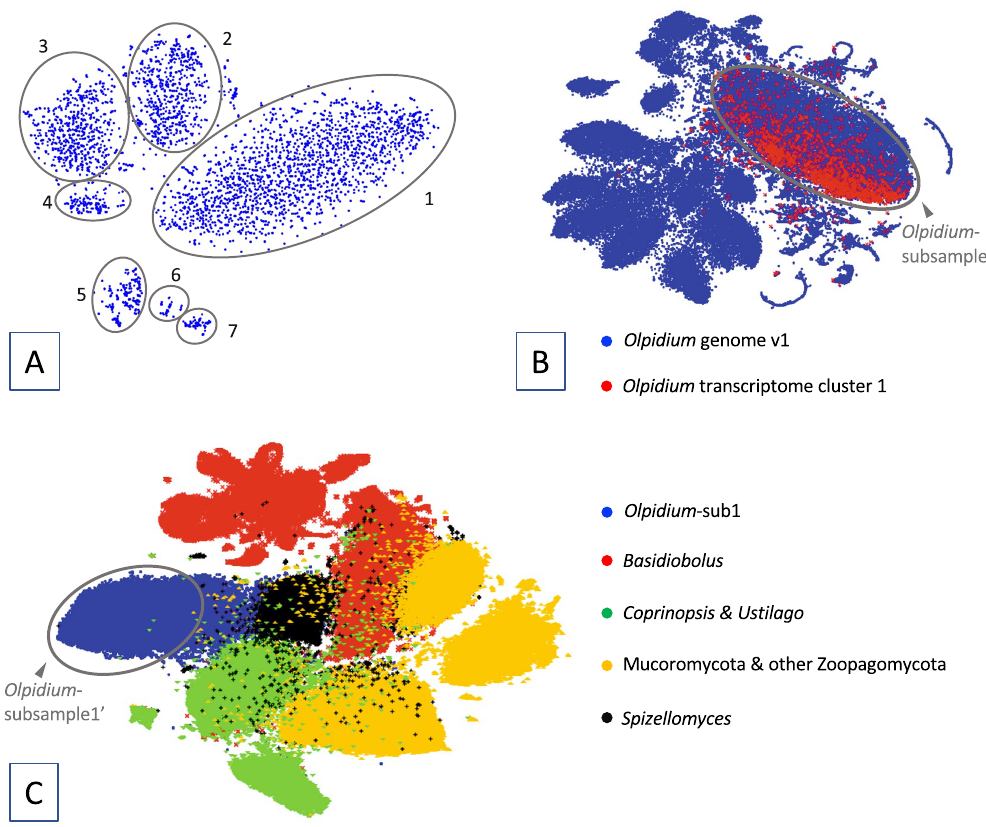
Figure 1. Metagenomic data binning of the transcriptome and genome assemblies of Olpidium bornovanus based on tetramer nucleotide composition using Vizbin. (A) Vizbin analysis on the transcriptome. Contigs shorter than 1.5 kb were removed from the analysis. The ovals delimit the seven data clusters recovered in the Vizbin analysis. (B) Vizbin analysis on the Olpidium- raw-genome assembly. Contigs longer than 1 kb in the genome assembly (blue data points) and contigs from transcriptome cluster 1 (red data points) were included in the analysis. The oval delimits Olpidium- subsample1, the subset of contigs used in the third Vizbin analysis. (C) Vizbin analysis on Olpidium- subsample1 (blue data points). Genome sequences from another seven fungal species were included in the same Vizbin analysis to serve as spike sequences. Contigs from the area that the Olpidium -subsample1 contigs show little overlap with the spike sequences were sampled ( Olpidium- subsample1 ′ ) and further binned using methods based on sequence similarity (mmseq2 and DIAMOND blastx) to produce the working